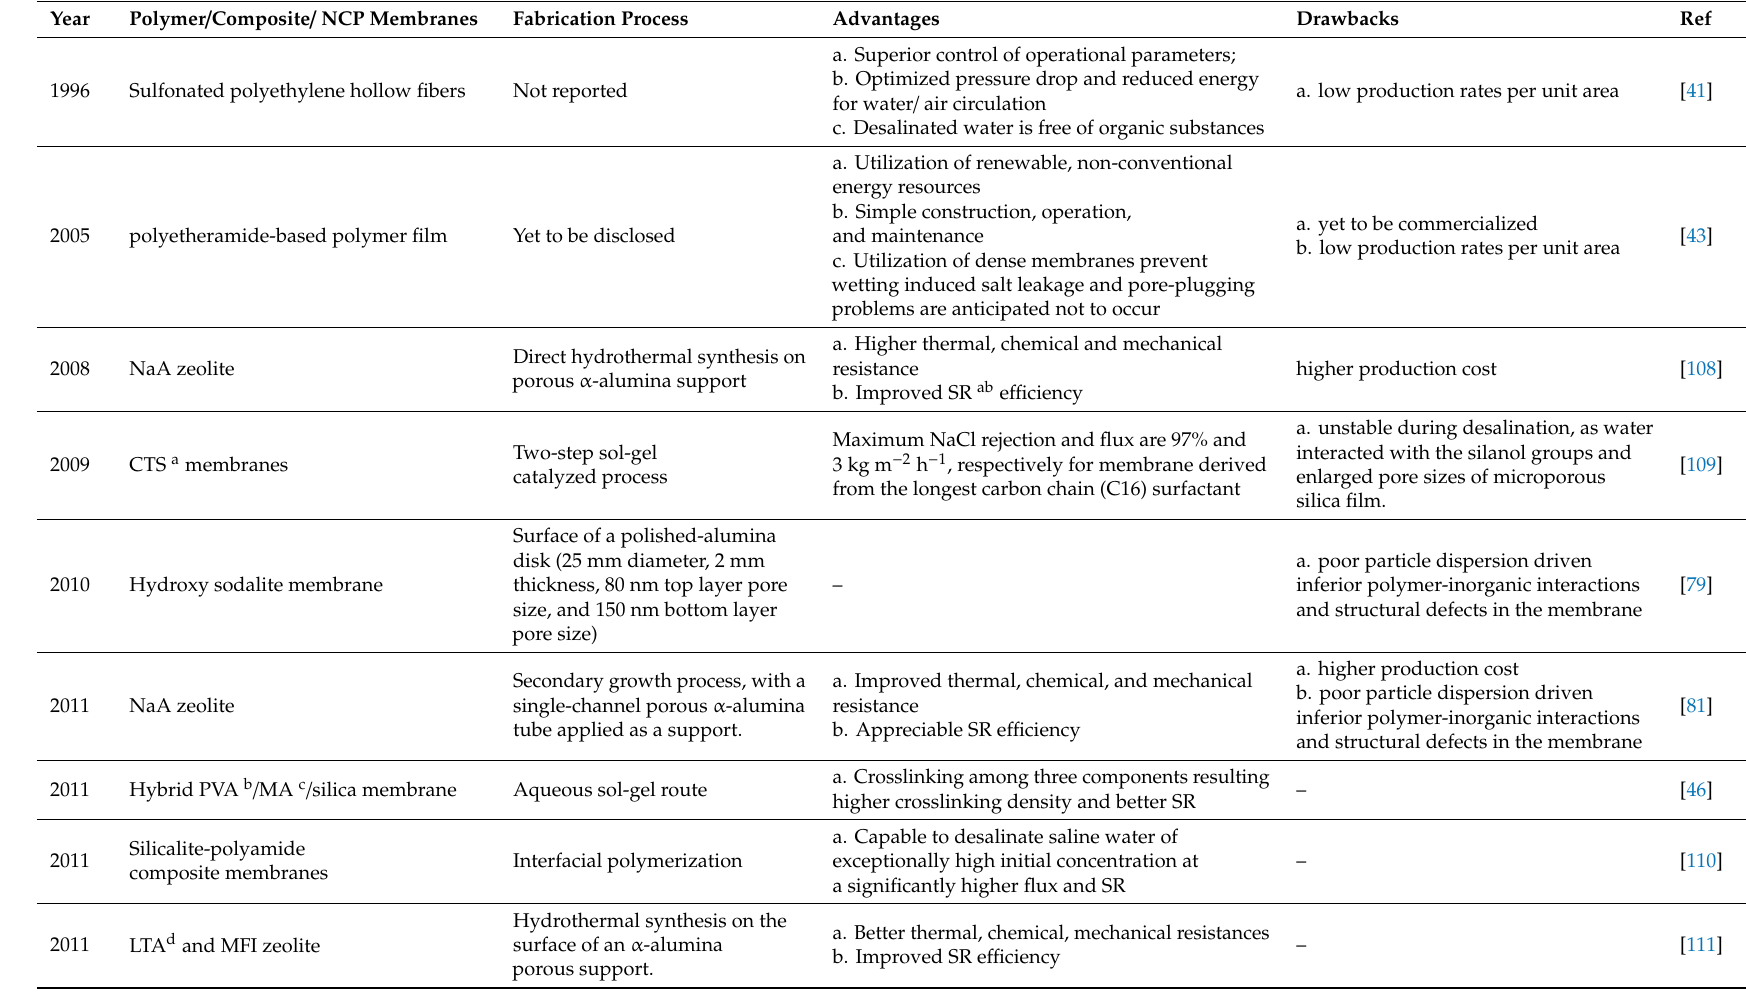
Table 1. Chronological order relating to the development of pervaporative desalination by di ff erent